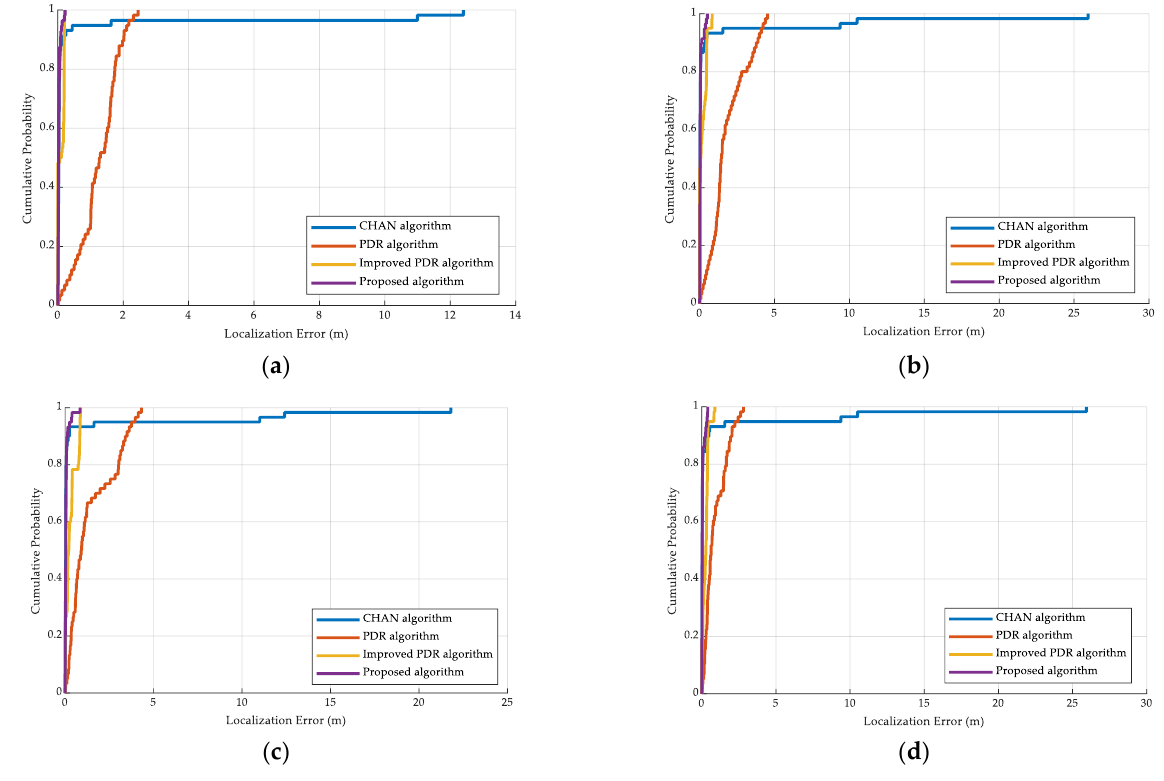
Figure 18. The CDFs of the localization errors among the CHAN algorithm, PDR algorithm, improved PDR algorithm, and the proposed algorithm in the second scene. ( a ) Volunteer #1 with a VivoY85a cell phone (scene 2). ( b ) Volunteer #2 with a VivoY85a cell phone (scene 2). ( c ) Volunteer #1 with an Honor60 cell phone (scene 2). ( d ) Volunteer #2 with an Honor60 cell phone (scene 2).